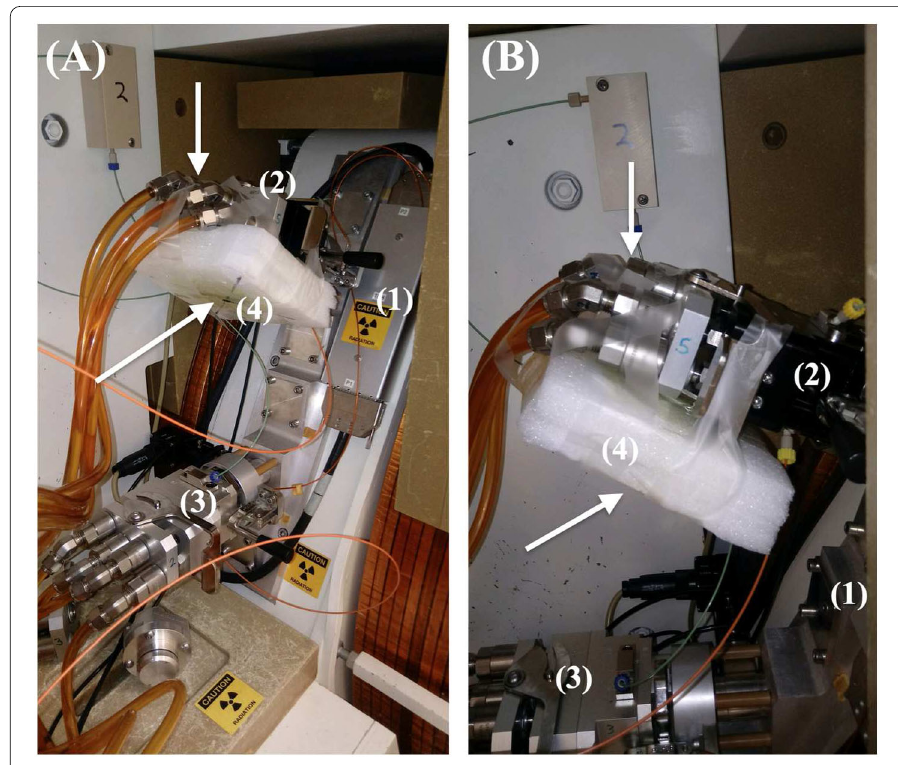
Figure 1 ( A ) Experimental setup for irradiation of Mo metal samples on a biomedical cyclotron (1) using high yield 18 F targets from BTI Targetry. White arrows indicate the position of the samples to be irradiated on the primary 18 F target (2) located in position 5, vertically located above a second 18 F target in position 2 (3). The top arrow is pointing to the Mo metal block attached directly behind the target, and the bottom arrow is the location of the Mo metal foils behind a Styrofoam moderator (4). ( B ) Close-up view of the 18 F target and Mo sample configurations from the perpendicular perspective relative to the incoming beam